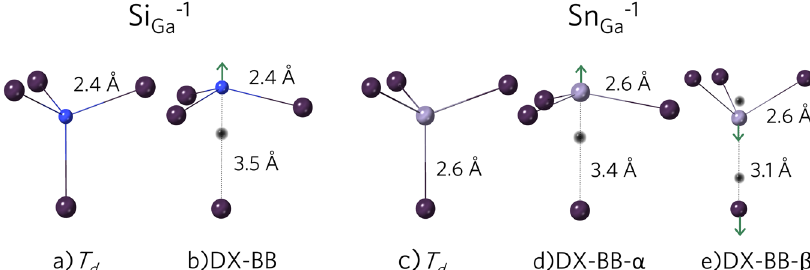
Fig. 7 Ground state ( T d ) and low energy metastable con fi gurations identi fi ed for Si (cid:1) 1 con fi guration consists of a C 3v distortion, where Si (Sn) displaces away from the original Ga position, breaking a dopant-As bond. In the DX-BB- β con fi guration, a Sn-As bond is also broken, but in this case, As undergoes the largest displacement. Si in blue, Sn in grey and As in purple. The arrows illustrate how the atoms reconstruct from the T d con fi guration and the black spheres depict the original position of the displaced atoms in the T d structure.